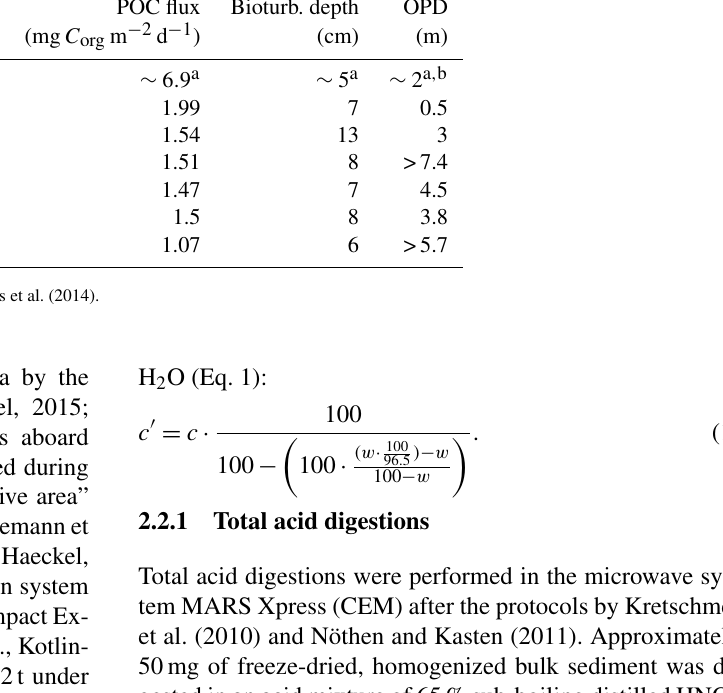
Table 2. Information of sedimentation rate (Sed. rate), flux of particulate organic carbon (POC) to the seafloor, bioturbation depth (Bioturb. depth), and oxygen penetration depth (OPD) based on GC cores from the investigated sites and determined in the study by Volz et al. (2018). Information for the BGR-PA area is taken from an adjacent site (A5-2-SN; 11 ◦ 57.22 (cid:48) N, 117 ◦ 0.42 (cid:48) W) studied by Mewes et al. (2014) and Mogollón et al. (2016). Area Sed. rate POC flux Bioturb.